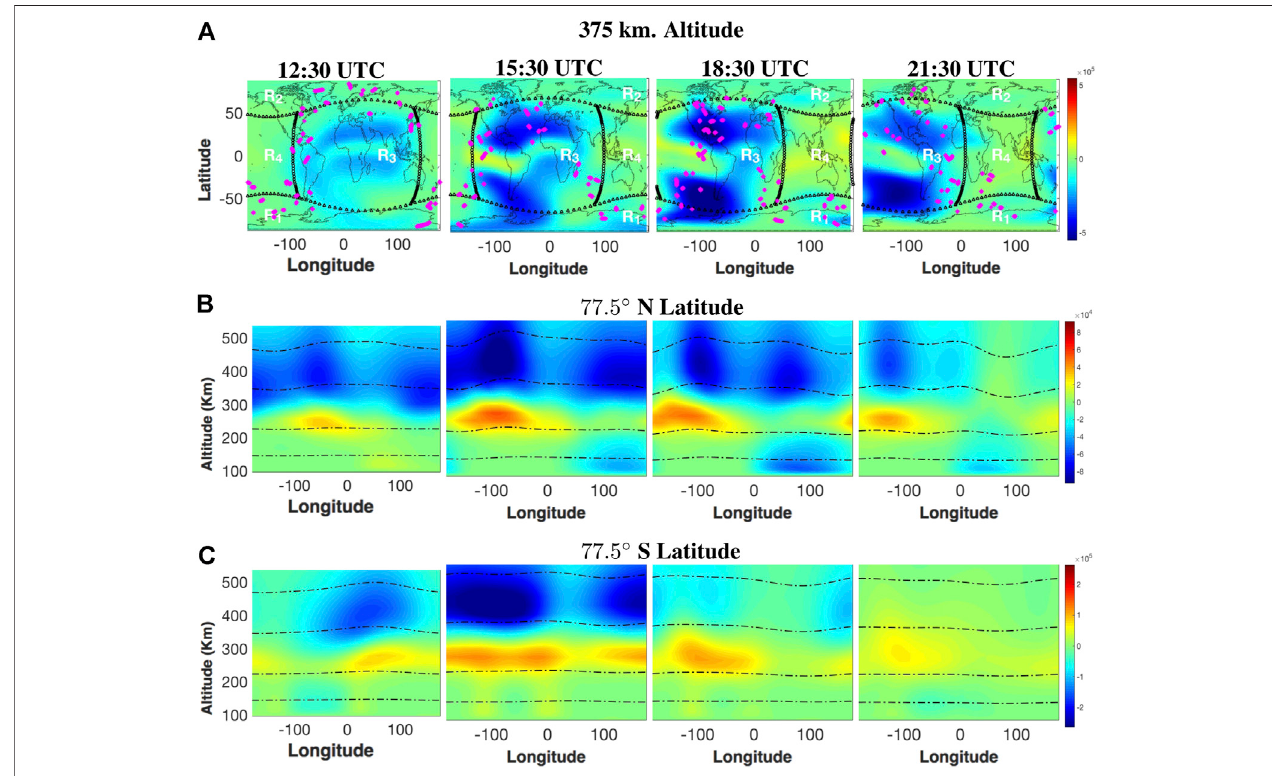
FIGURE2|(A) Globalmapsofelectrondensitybiasinunitsofel / m 3 ,ata fi xed375 kmaltitudeattheindicatedtimesonSeptember26,2011.Theelectrondensity biasiscomputedasdeviationfromthetruthoftheensemblemeanoftheforecast ( e b − e t ) .Theblackcurvesdenotetheboundariesofthegeographicalregions,labeled in white, that partition the domain horizontally. The locations of the COSMIC vertical pro fi les at each time are shown with the magenta markings. (B) Vertical structure of electron density bias at a fi xed 77.5 ° N latitude at 11:30, 15:30, 19:30 and 23:30 UTC on September 26, 2011. The vertical partitioning of the domain is denoted withtheblackcurves,whichcorrespondtopressurelevels − 2.5,0,2.5,and5. (C) Analogousplotsoftheelectrondensitybiasverticalstructureata fi xed77.5 °